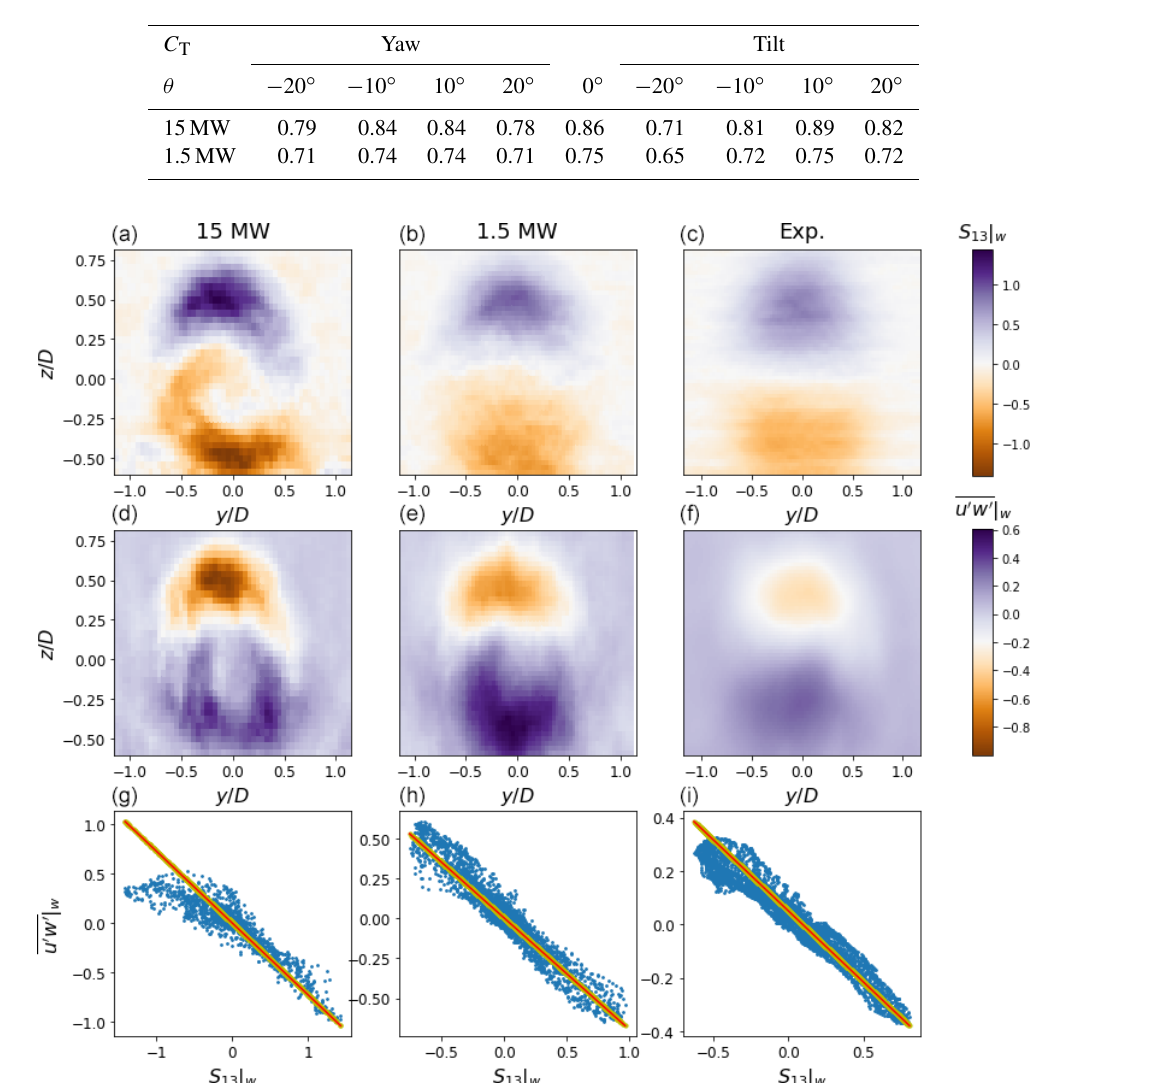
Table 1. Time-averaged thrust coefficients for the 15 and 1.5MW LES cases.